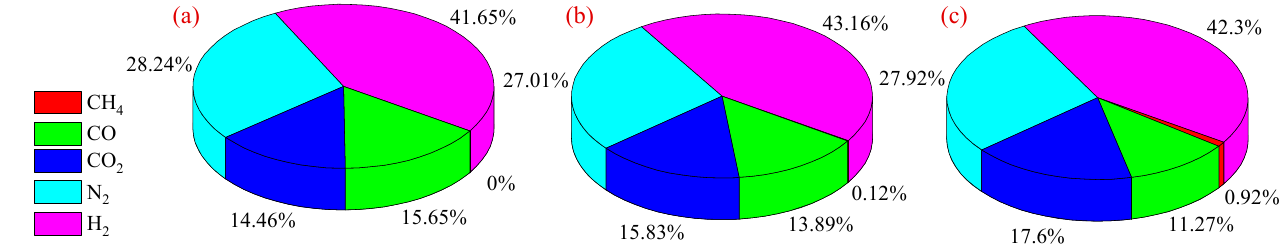
Figure 12. The results of GC analysis in different pressure environments: ( a ) vacuum environment; ( b ) atmospheric environment; ( c ) high chamber pressure environment.